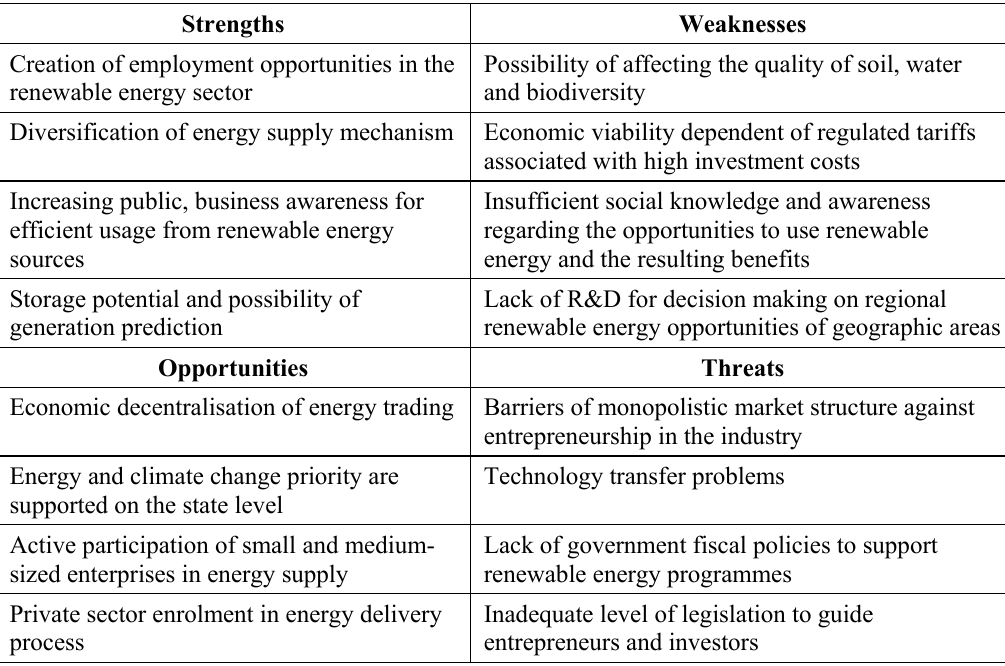
Table 2. SWOT Analysis (prepared by the